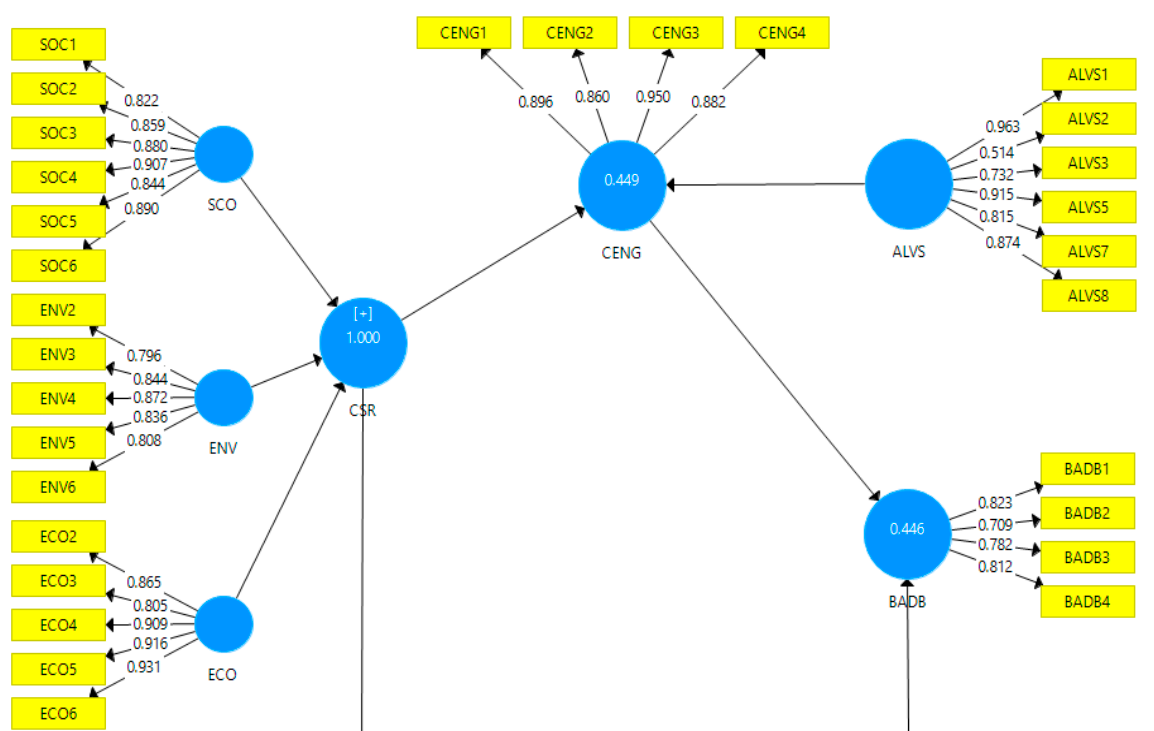
Figure 2. Measurement Model. CSR = corporate social responsibility, ALVS = altruistic values, CENG = consumer engagement, BADB = brand advocacy behavior, SCO = social dimension, ENV = environmental dimension, ECO = economic dimension.